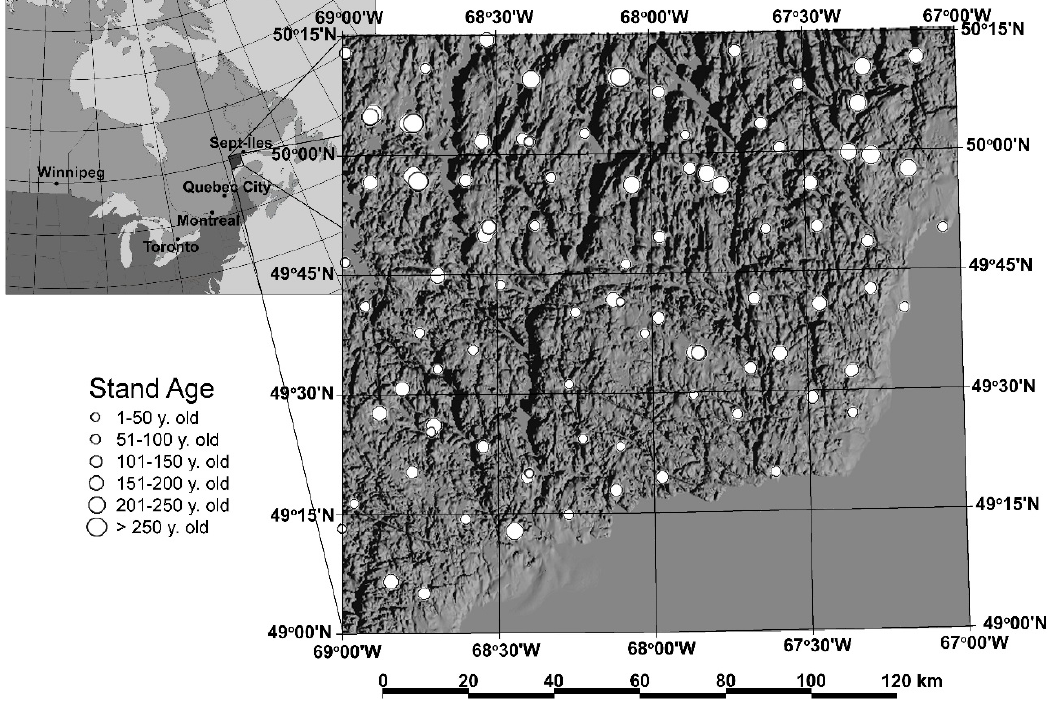
Figure 2. Case study area and empirical dendroecological survey ( n = 94). Stand age can be associated with either a known TSF (uncensored) or a minimum TSF (censored). Topography is amplified 10